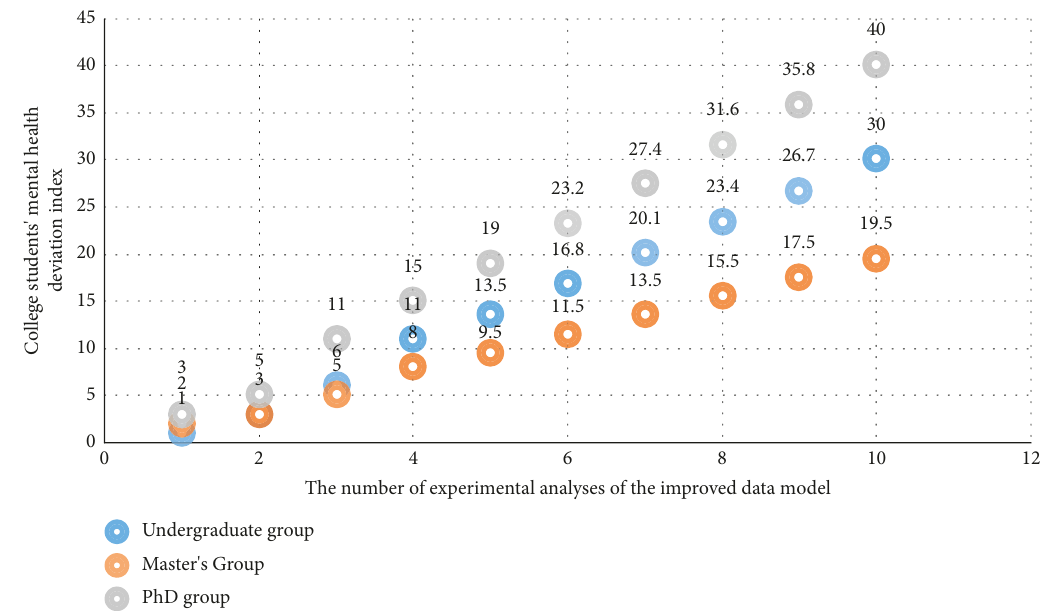
Figure 7: Analysis results of the improved data model and data